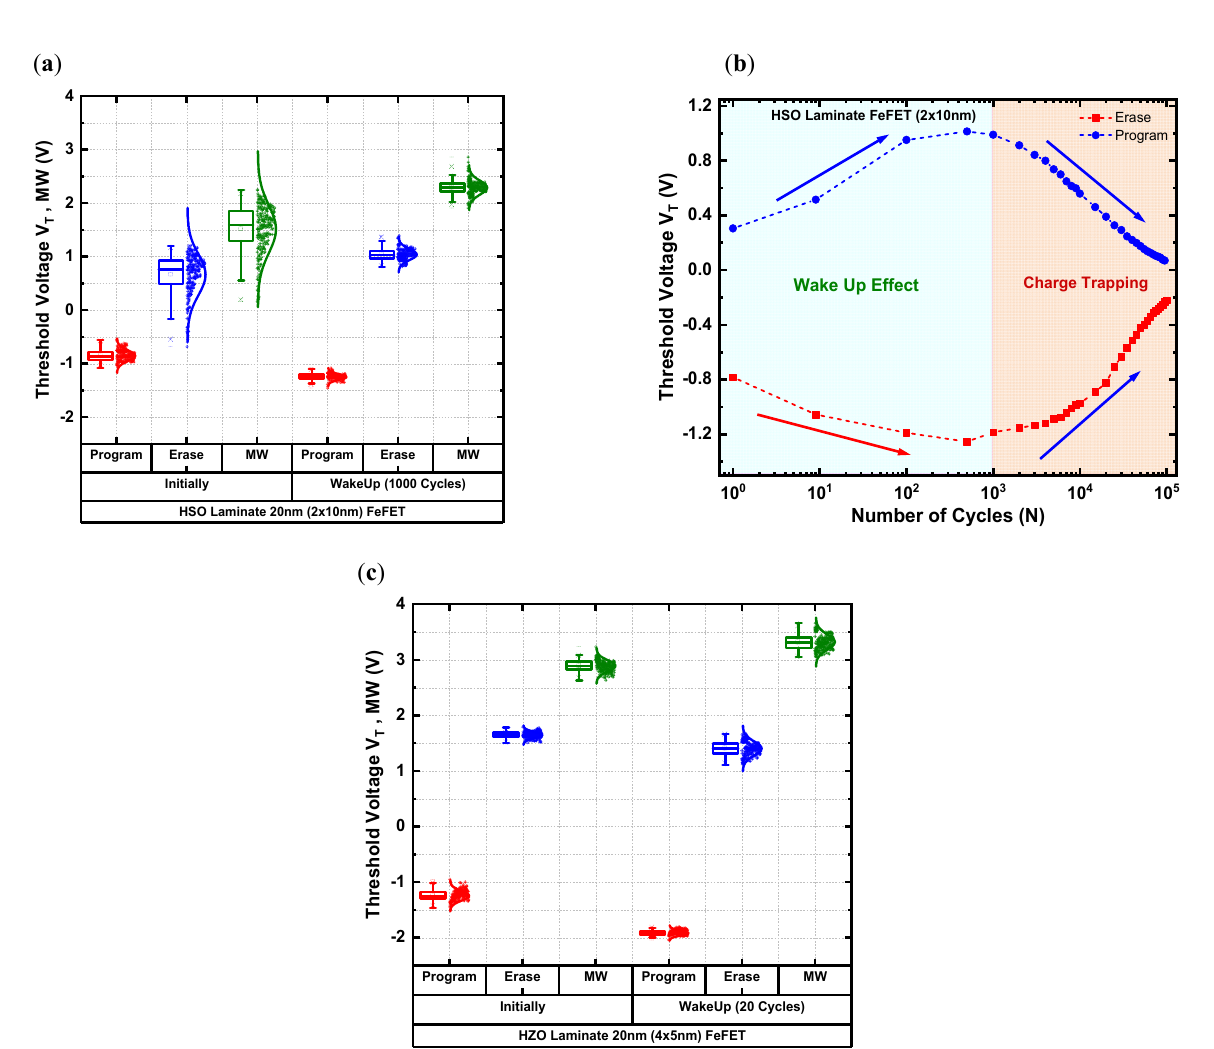
Figure 12. The effect of wakeup and charge trapping on the switching characteristics of ( a ) the HSO laminate stack with ( b ) the V T evolution over cycling; ( a ) the HSO laminate stack in comparison to ( c ) the HZO laminate stack. PG/ER and cycling conditions are based on Figure 8. Reproduced with permission from [17] T. Ali et al., IEDM; published by IEEE, Copyright 2019, IEEE.